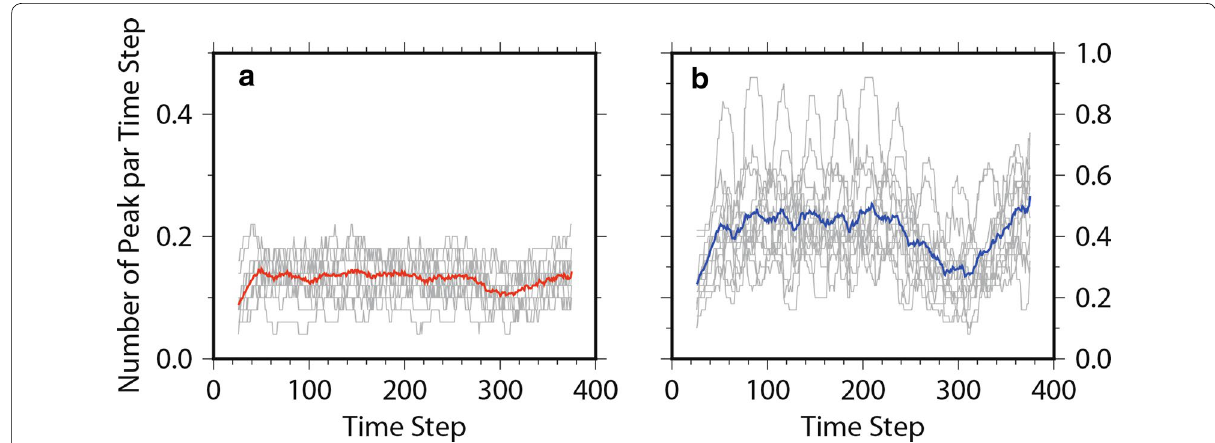
Fig. 9 Number of peaks per time step, averaged over 50 time steps, from the 15 simulations. In a and b , peaks in ˙ M 0 (corresponding to the red points in Fig. 7) and in the local slip rate ( blue points in Fig. 7, selected for a peak rate higher than 0.02 m/ (cid:31) t ) are shown, respectively, as a function of time step. The bold colored curves are the average values for all the simulations